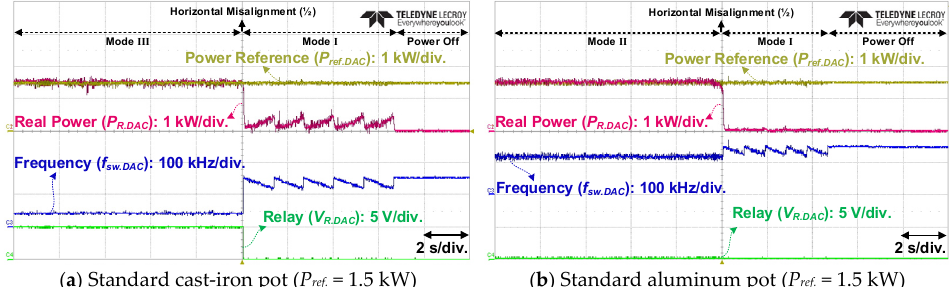
Energies 2019 , 12 , x Figure 18. Waveforms of horizontal misalignment for pots during IH. Figure 18. Waveforms of horizontal misalignment for pots during IH.